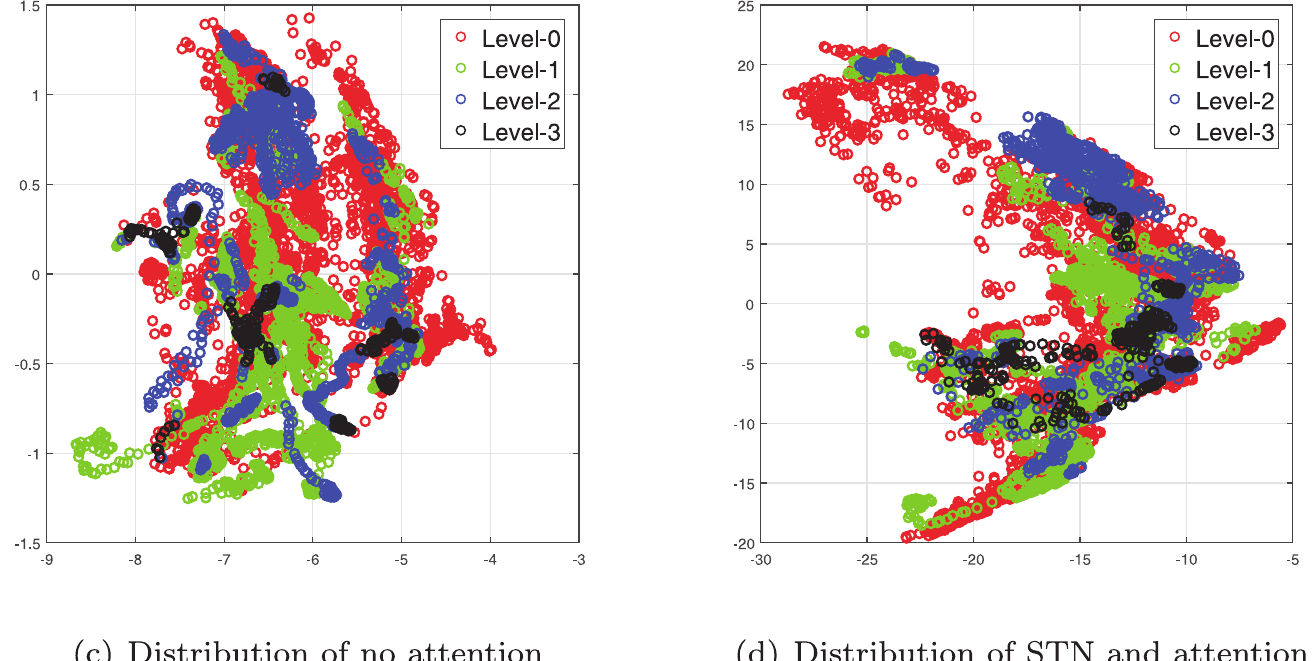
Fig 5. The feature distribution in different modes. First, the PCA algorithm is used to reduce the feature (i.e., the response of the last fully connected layer) dimension to 2. Then, we plot the reduced features in a 2D space.